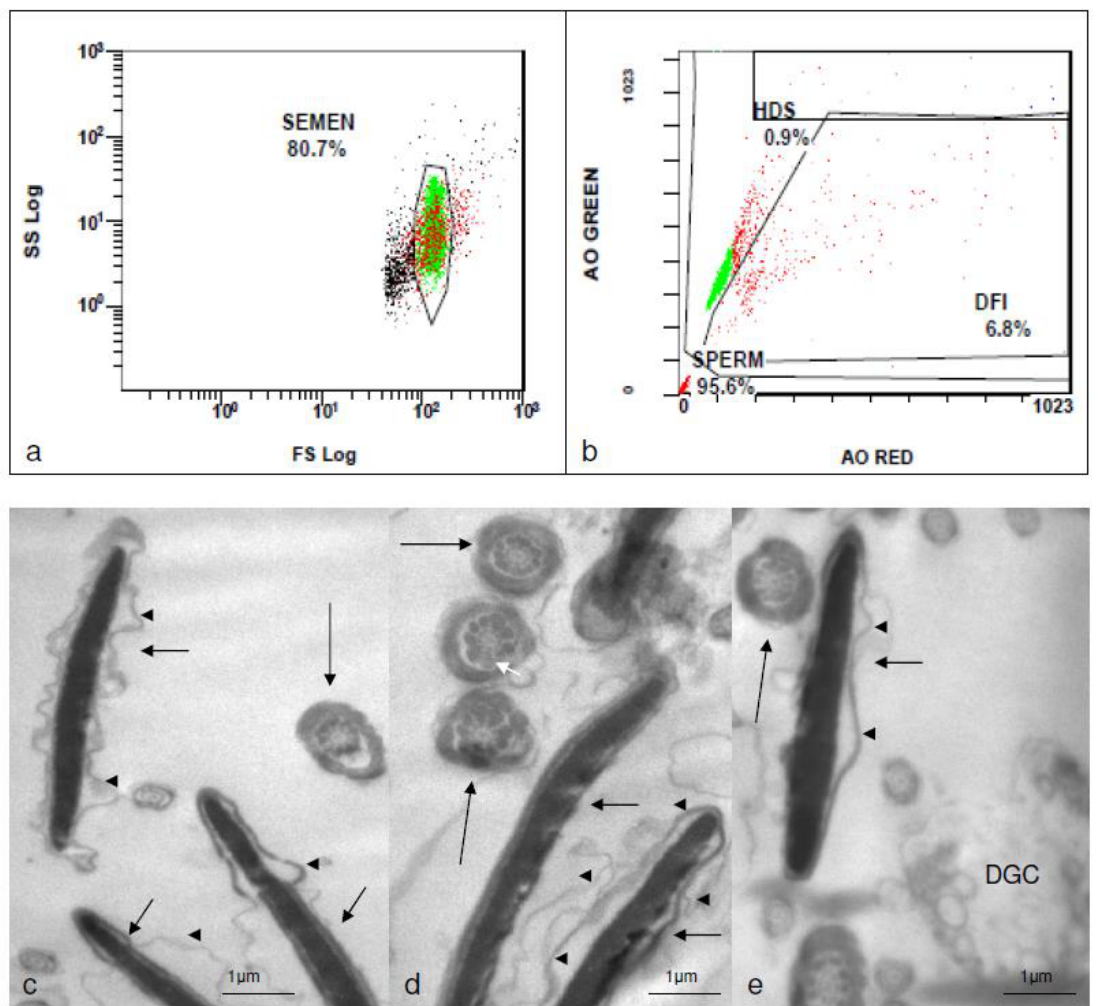
Figure 1. Assessment of DNA fragmentation by flow cytometry ( a , b ) and TEM photomicrographs ( c – e ) of the fresh sample under therapy with Golimumab and after 3 doses of mRNA vaccine for COVID-19. Note that in ( c – e ) the very elongated heads (arrows), the abnormal cytoplasmic membranes (arrow heads), and the normal outer dense fibers and axonemes (long arrows). It is possible that an outer dense fiber is missing in the middle structure (white arrow) in ( d ). Additionally, note the degenerate cell (DGC) in ( e ).